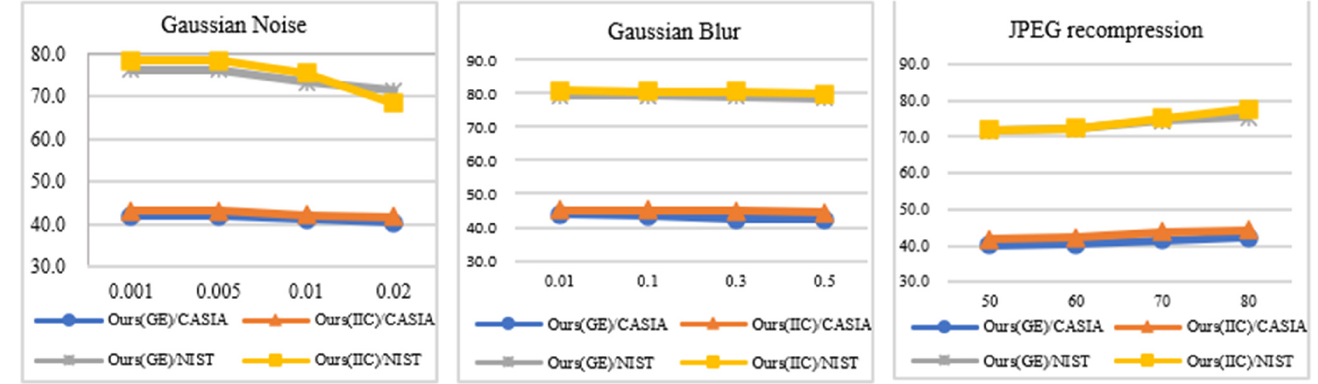
Figure 5. Robustness validation of F 1 scores on CASIA and NIST16 dataset.